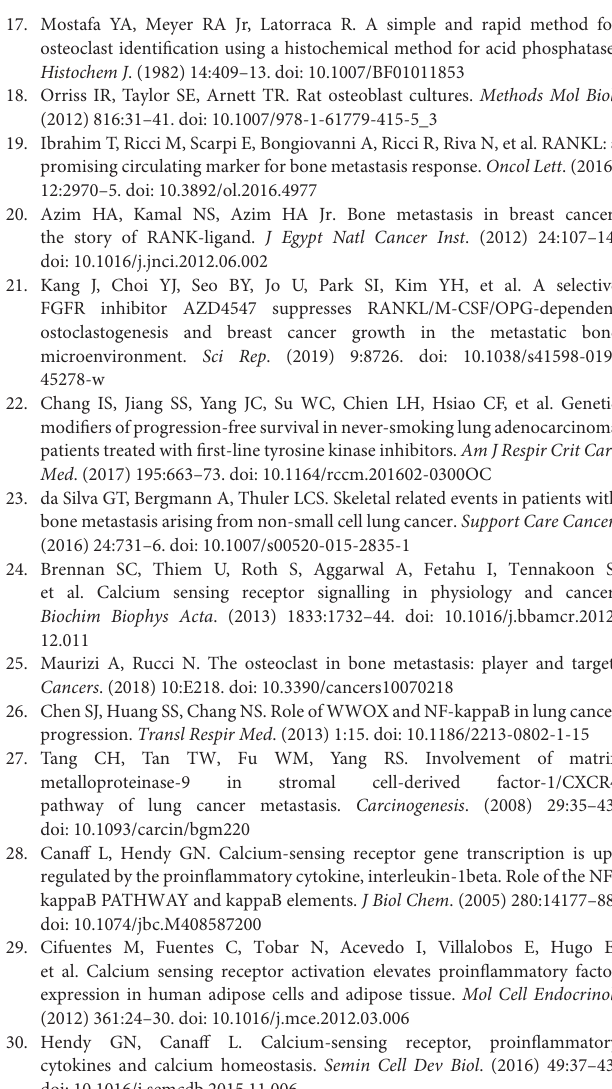
counted using 400-fold microscope and TRAP-stained OC area was calculated using ImageJ software (NIH). OC number and osteolytic area size in CaSR overexpression A549 cells plus macrophages group (oeCaSR + M Φ ) were significantly higher than those in CaSR knock-down A549 cells plus macrophages group (siCaSR + M Φ ), the CaSR-modulated A549 cells alone groups (siCaSR and oeCaSR), and the macrophages alone group (M Φ ) ( p < 0.001). The difference